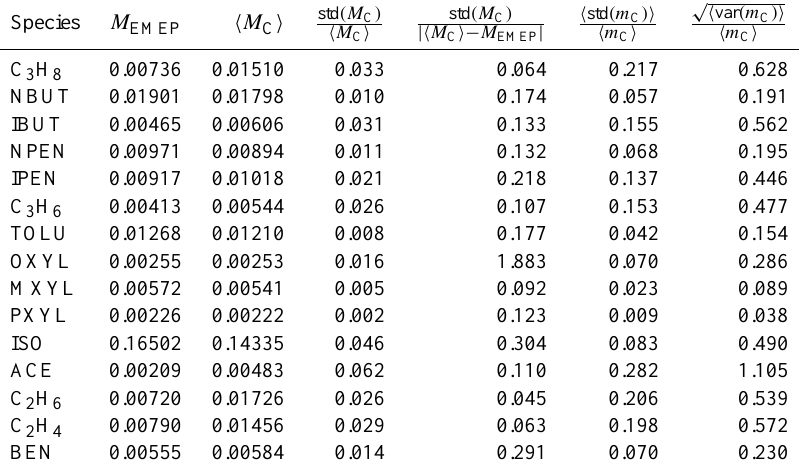
Table 10. Monte Carlo estimation of the uncertainty of the correction to the EMEP emission inventory yielded by data assimilation in case C. M EMEP : the total 2005 emitted mass for EMEP inventory (in Tg), h M C i ; the total mean reconstructed emitted mass (in Tg); std (M C ) h the standard deviation (std.) of the reconstructed mass normalised by the mean reconstructed emitted mass; std (M C ) |h deviation of the reconstructed mass normalised by the difference in absolute value between the reconstructed mass and the EMEP emission h std (m C ) i mass; h m C i : the arithmetic mean of the standard deviations of the individual emission fluxes normalised by the mean emitted mass in a grid cell; : the quadratic mean of the standard deviations of the individual emission fluxes, normalised by the mean emitted